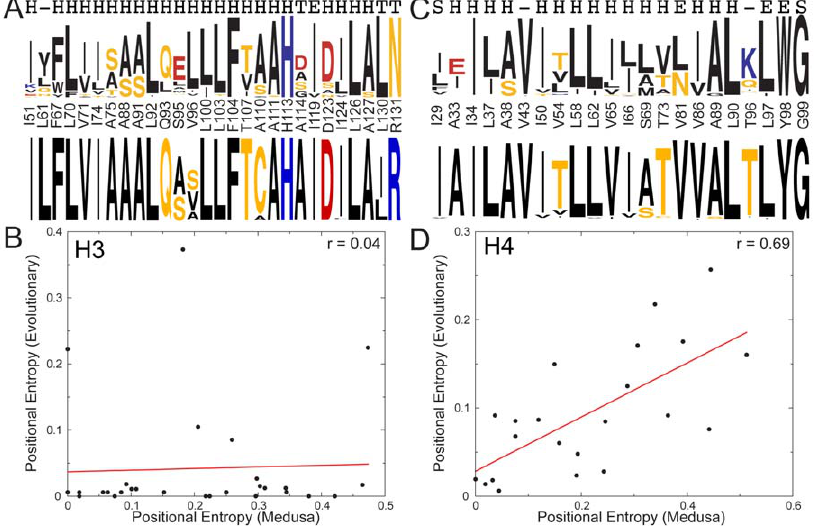
Figure 3. Evolutionary and calculated sequence entropies have significant correlation in H4 but no correlation in H3. A , C , Sequence logo (http://weblogo.berkeley.edu/) of propensities of different amino acids calculated using Medusa at each of the buried/interface residues show that Medusa recapitulates 75% of positions in H3 ( A , top logo) and 54.5% of positions in H4 ( C , top logo). For comparison, the corresponding sequence logo from evolutionary conservation (obtained from homology-derived secondary structure of proteins (HSSP) database) is also shown for H3 ( A , bottom logo) and H4 ( C , bottom logo). The amino acids are colored according to their physical property (hydrophobic amino acids are colored black, negatively charged red and so on). The secondary structure corresponding to each amino acid is shown at the top: helix (H), beta strand (E), hydrogen bonded turn (T), bend (S) or no secondary structure (-). B , D , Plotting positional entropy of buriedresidues in H3 andH4 calculated using Medusa against evolutionary positional entropy shows no correlation for H3 ( B ) and significant correlation for H4 ( D ). Each point in the plots represents a specific buried/interface residue. The actual values of Evolutionary and Medusa entropies are represented in Supplementary Tables 3 and 4.